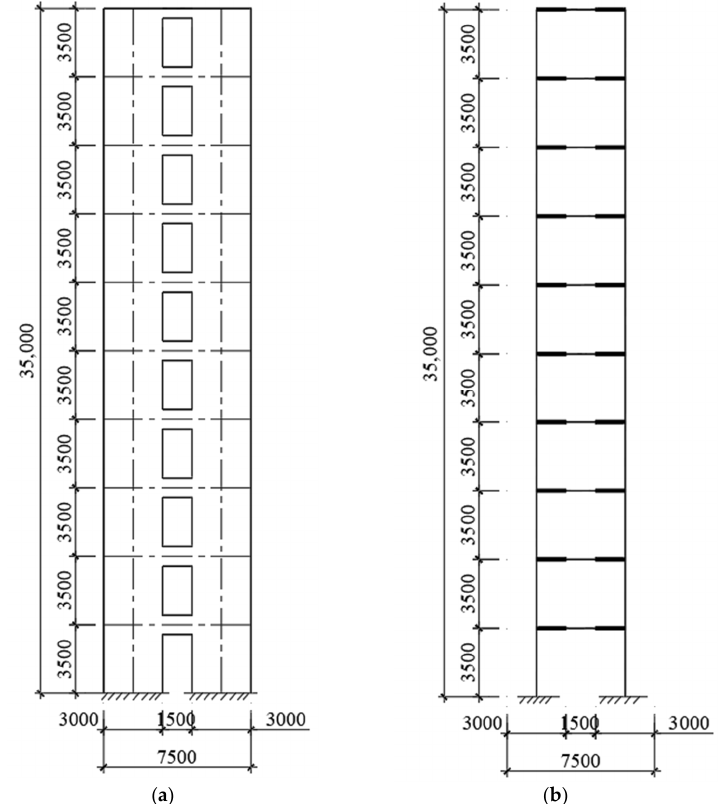
Figure 16. Ten–story coupled shear wall: ( a ) Coupled shear wall; ( b ) Frame analogy. To verify the accuracy and efficiency of the proposed program in analyzing the non- linear response of coupled shear wall with energy dissipation device under earthquake loading. There are two cases of placing energy dissipation devices at different locations device located on the 1st floor and the device added from the 3rd to 5th floor, to be inves- tigated. The peak lateral displacement, base shear, peak floor acceleration, and base mo- ment of the building of the first case, respectively, generated by the AFD program and SAP2000 are shown in Figure 17. Moreover, Figure 18 illustrates peak lateral displace- ment, base shear, peak floor acceleration, and inter-story drift ratio of coupled shear wall with the device at floors 3 to 5. It can be observed that the responses of the structure under earthquake obtained by the proposed program AFD and SAP2000 are nearly the same.